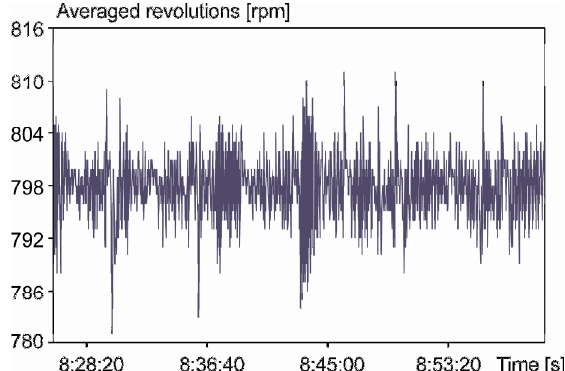
Fig. 8. Histogram of total input power of bucket wheel